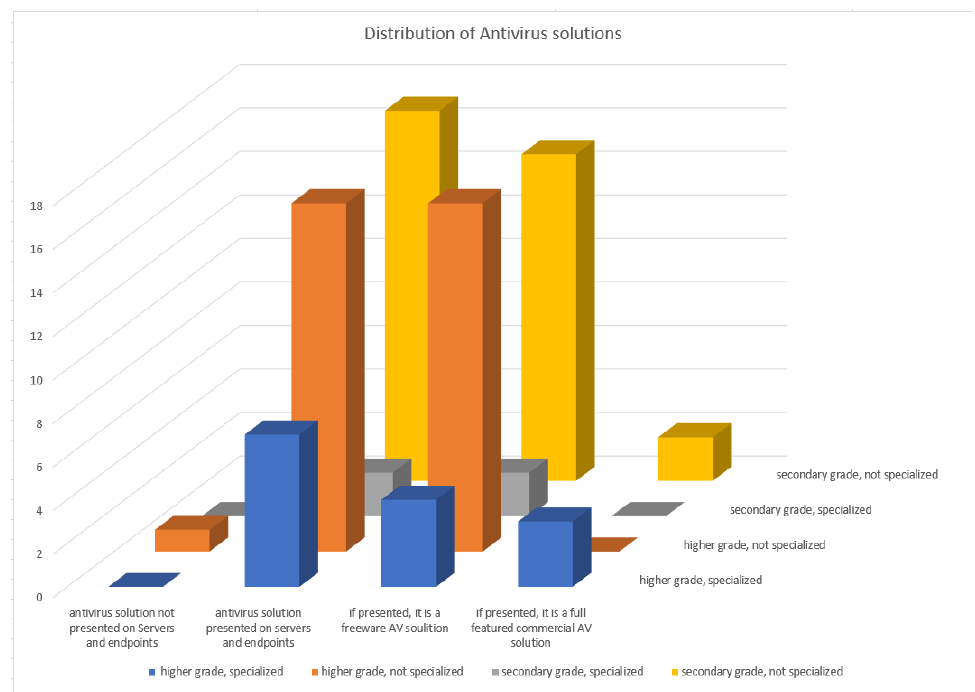
Figure 8. Present AV solutions in companies related to the decision makers IT